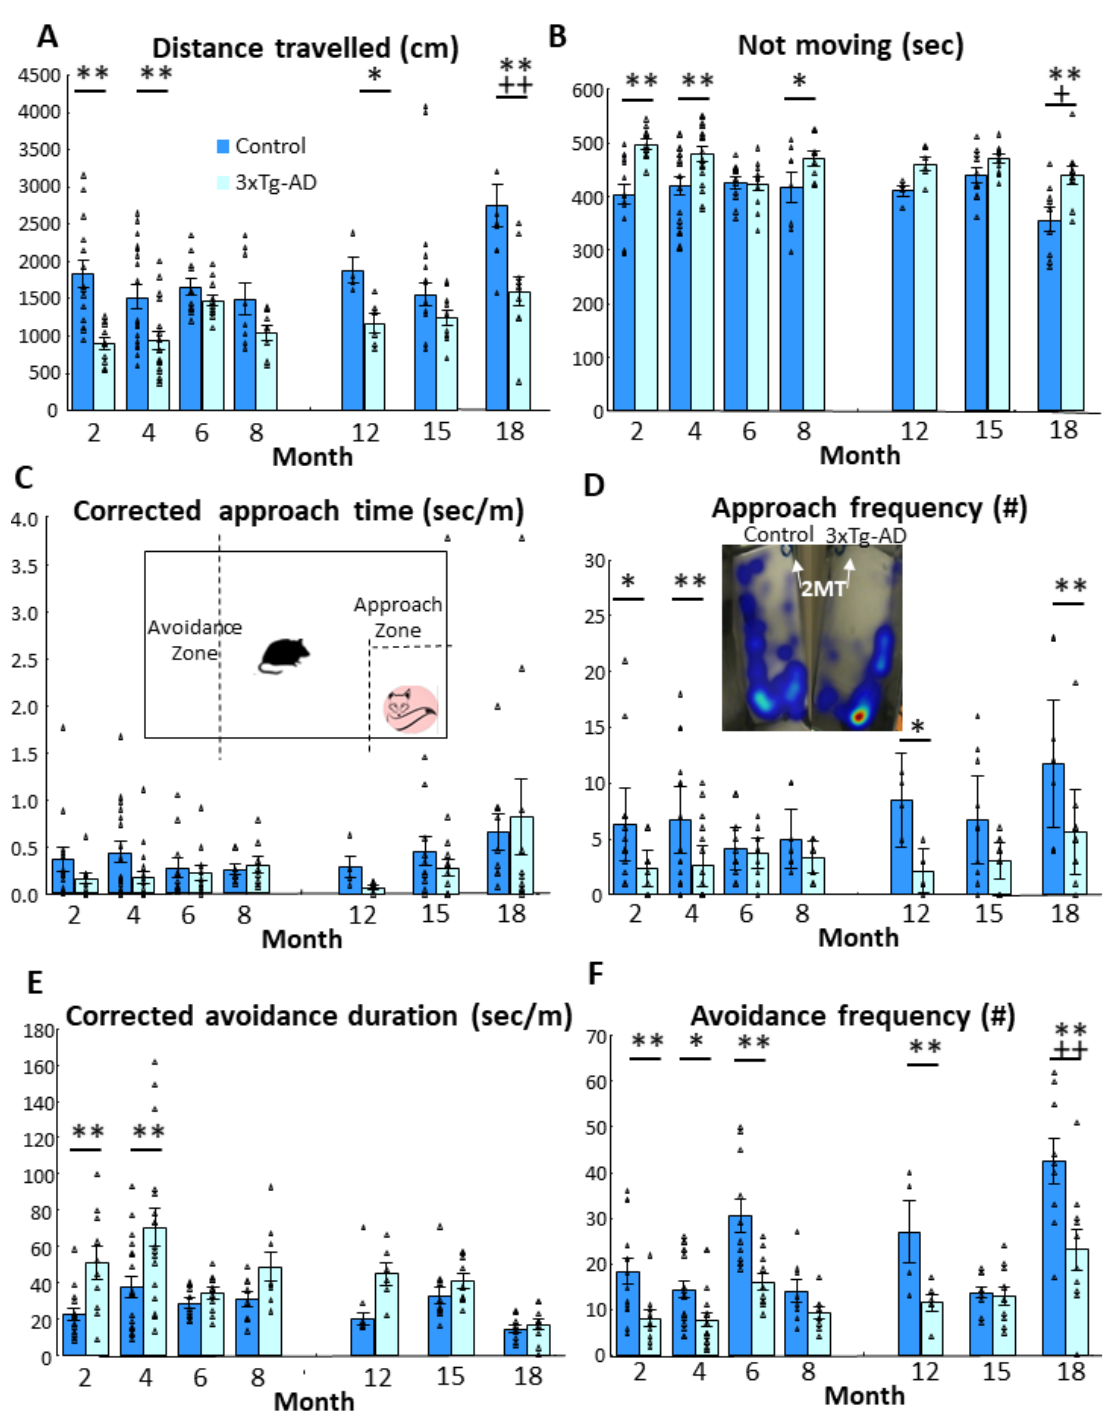
Figure 1. Fox odor avoidance behavior in male mice in different age groups (2, 4, 6, 8, 12, 15 and 18 months). ( A ) Distance travelled in centimeters during 10 min. The 3xTg-AD animals moved signif- icantly less than the control animals ( p < 0.01). Additionally, the control groups moved more with age (age: p < 0.01, genotype × age: p = 0.05). ( B ) Time spent without movement (“freezing”). Consist- ently with the previous result, the 3xTg-AD animals spent more time immobile ( p < 0.01). In both groups, the tendency to freeze decayed with age ( p < 0.01). ( C ) Corrected approach time to fox odor zone and representative image of the fox odor test. Due to differences in locomotion between the genotypes we opted to measure the approach time in s/m. In both groups, older animals spent more time near the fox odor (2-methyl-2-thiazoline, 2MT; p < 0.05). ( D ) Frequency of approaching the odor zone and illustrative example of mouse activity by heatmap ( the warm (i.e., red) areas’ values are high and the cold (i.e., dark blue) areas’ values are low ). The 3xTg-AD approached the 2MT con- taining zone less frequently ( p < 0.01), however, this also increased with age ( p < 0.05). ( E ) Locomo- tion corrected time spent in the avoidance zone. The 3xTg-AD animals spent more time in the avoid- ance zone than their age matched controls ( p < 0.01). ( F ) Number of entering into the avoidance zone. As 3xTg-AD animals spent more time in the avoidance zone, they entered this zone less frequently